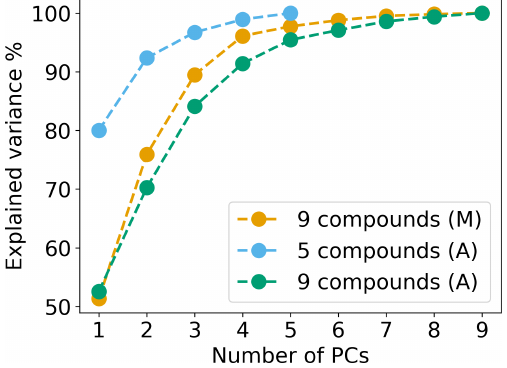
Figure 2. Cumulative explained variance for automated (blue and green) and manual (orange) compound